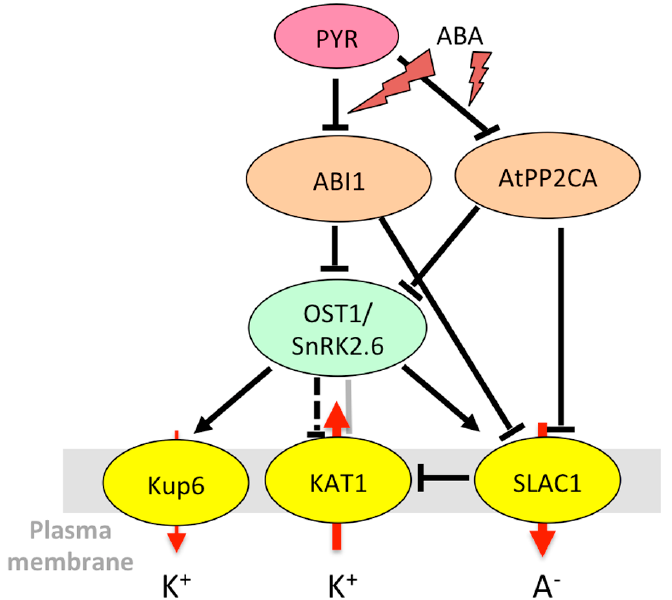
Figure 3. Model for the OST1 network leading to K + and anion fluxes in Arabidopsis guard cells. The dotted T-bar indicates that the effect might be indirect. See Figure 1 for details of the legend.